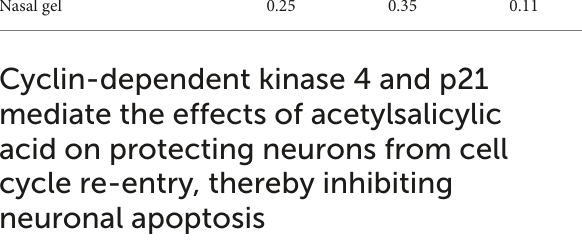
TABLE 7 The expression of cell cycle-associated genes in aspirin-administered mice. Genes hippocampus CDK1 CDK2 CDK4 CyA2 CyB1 p21 Solution 0.49 0.76 Nasal gel